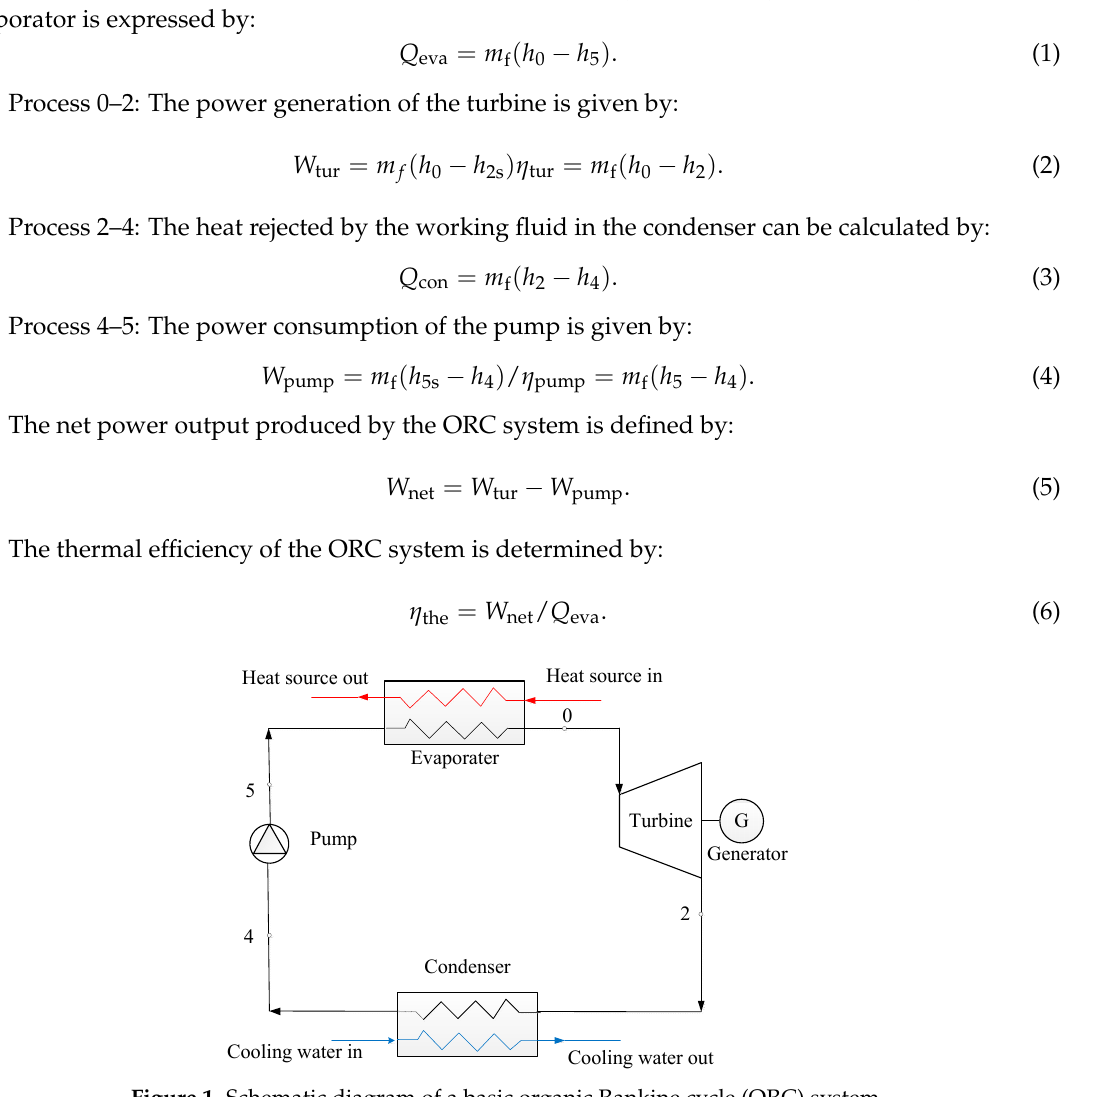
Figure 1. Schematic diagram of a basic organic Rankine cycle (ORC) system.